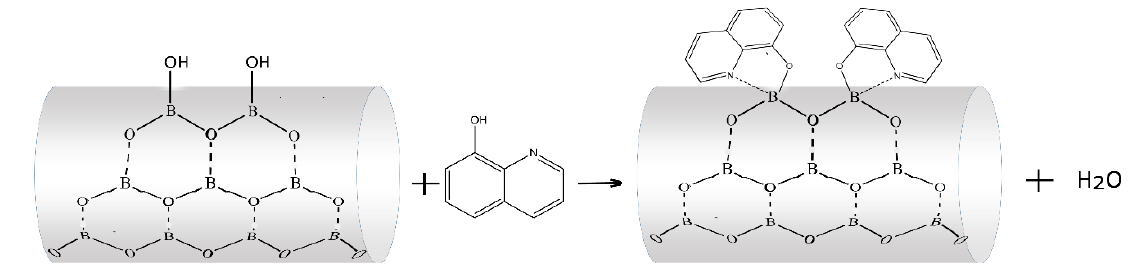
Figure 9. Scheme of the BLC formation of a smooth wire wall of boron oxide.